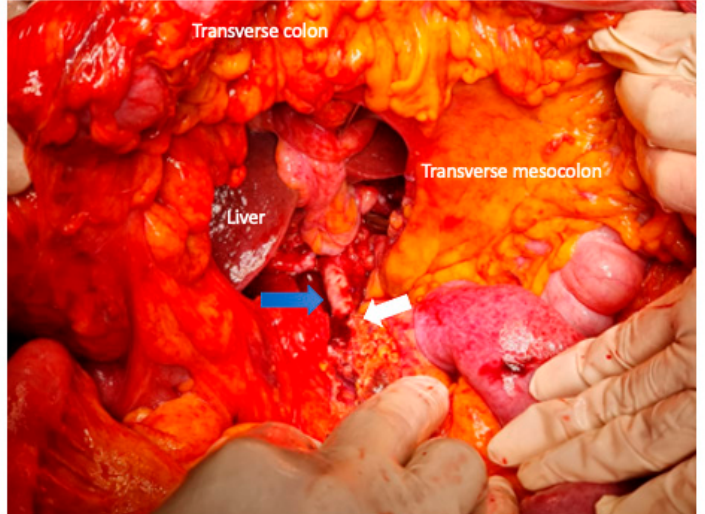
Figure 3. Identification of the superior mesenteric vessels (the blue arrow shows the superior mes- enteric artery) is performed at the root of the mesentery below the transverse mesocolon to the origin from the aorta. The middle colic artery is detached at its origin from the SMA in this manner (white arrow), and the tumor-infiltrated section of the transverse mesocolon is resected to remain with the